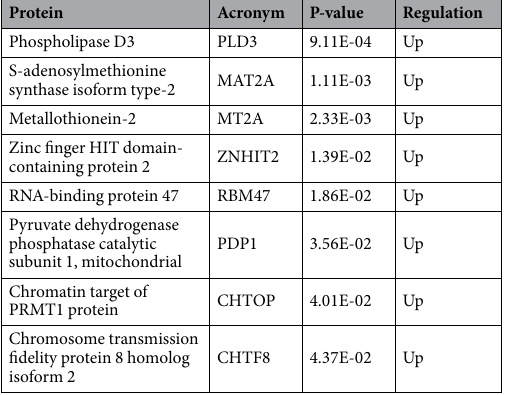
Table 1. Proteins significantly regulated following RAPTA-T treatment determined from FITExP analysis of MCF-7 and MDA-MB-231